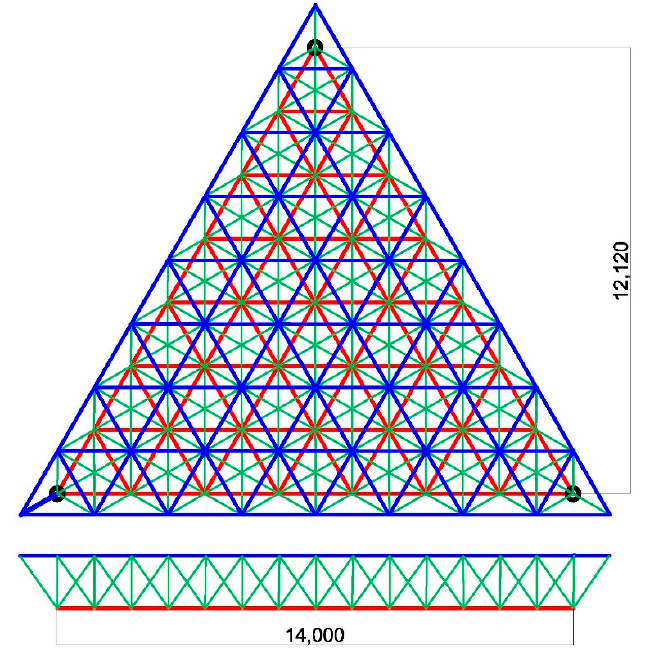
Figure 1. The scheme of the modular structural plate: a plan, a section (Dimensions are given in mm).